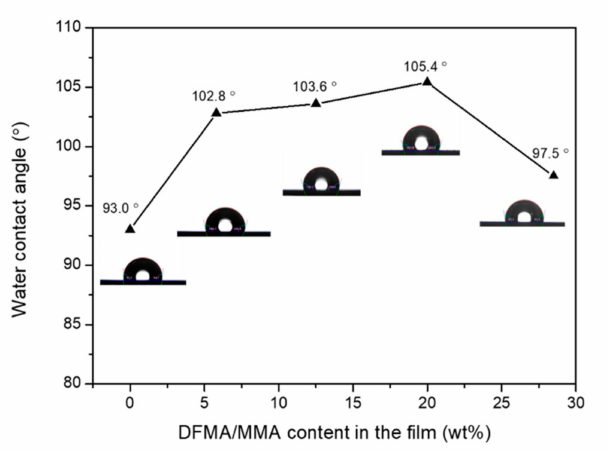
Figure 9. The water contact angle analysis of the as-prepared nanohybrid silica polyacrylate films prepared at different weight ratios of